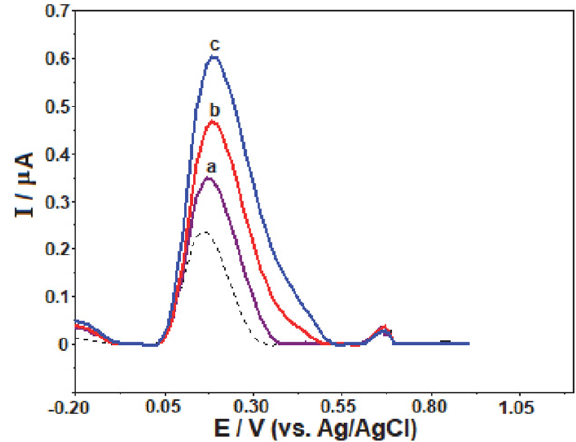
Figure 7. SW voltammograms of the diluted henna sample (dashed line) and after standard additions of 0.1 (a), 0.6 (b) and 1.0 (c) µM lawsone in 0.1 M phosphate buffer (pH 2.5) solution with 0.1 mM CTAB on BDD electrode. Other operating conditions as indicated in Figure 6.